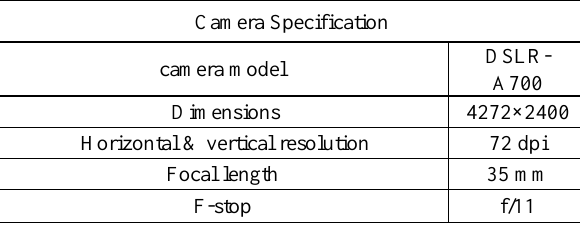
Table 1. SONY- DSLR-A700 camera specifications.